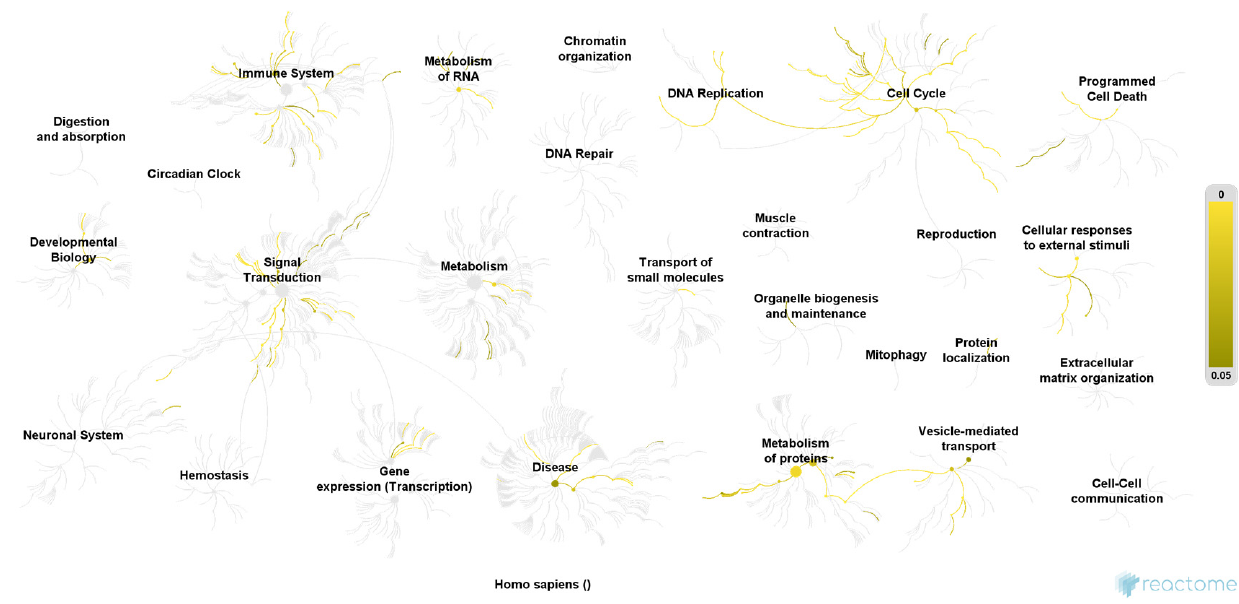
Figure 1. Pathway overview of the 27 most relevant proteins of the OAB group. Color codes indicate a hit in the respective pathway. Higher color intensity (yellow) means a higher significance of one or more proteins within this signal cascade (FDR). Reactome Pathway database, open access open source [22].